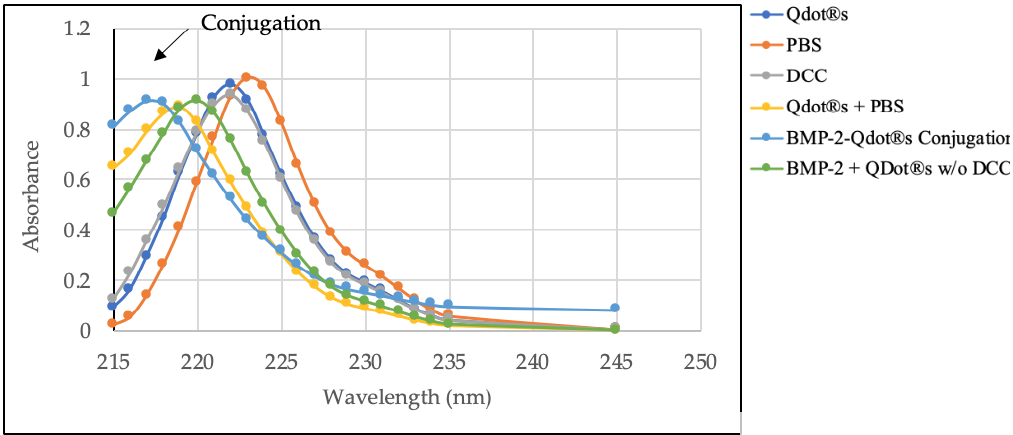
Figure 1. UV / VIS spectra of BMP-2-QDot ® s and five control fractions between wavelength 215–245 nm. BMP-2-QDot ® s was shifted left of the control samples, due to the absorbance of secondary amides.